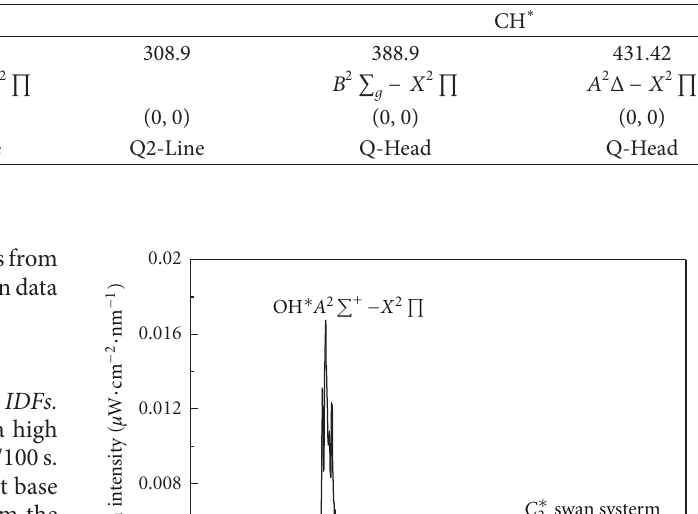
∗ maximum (condition